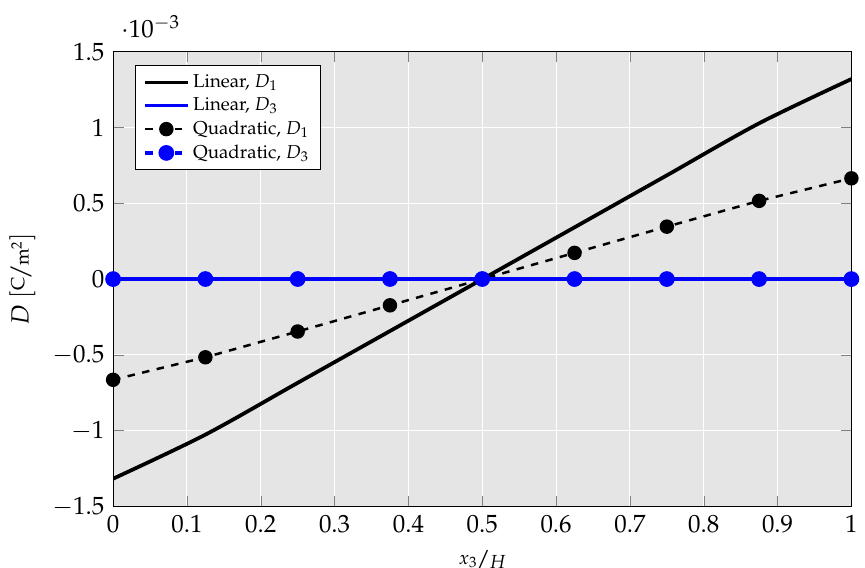
Figure 23. Comparison of electric displacement components calculated by using linear and quadratic element along the height of the beam for prescribed mechanical